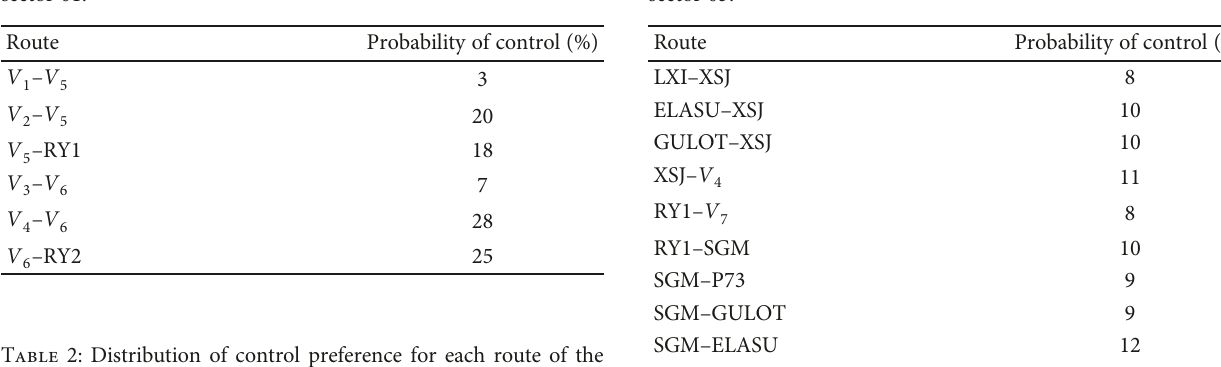
Table 3: Distribution of control preference for each route of the sector 03.